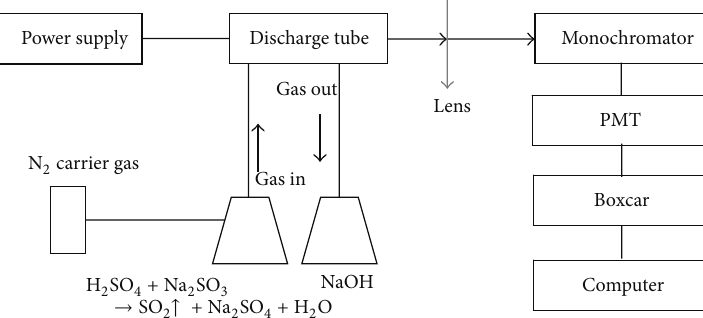
Figure 1: Diagram of the pulse streamer discharge system for SO 2